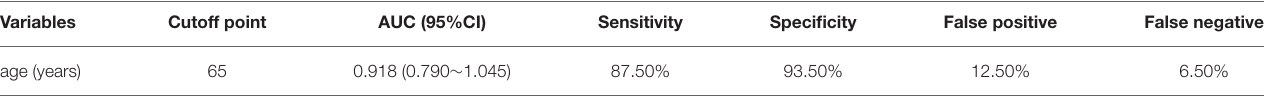
TABLE 11 | The performance of various methods for distinguishing between the dead cases and the survived patients( n = 718). Variables Cutoff point